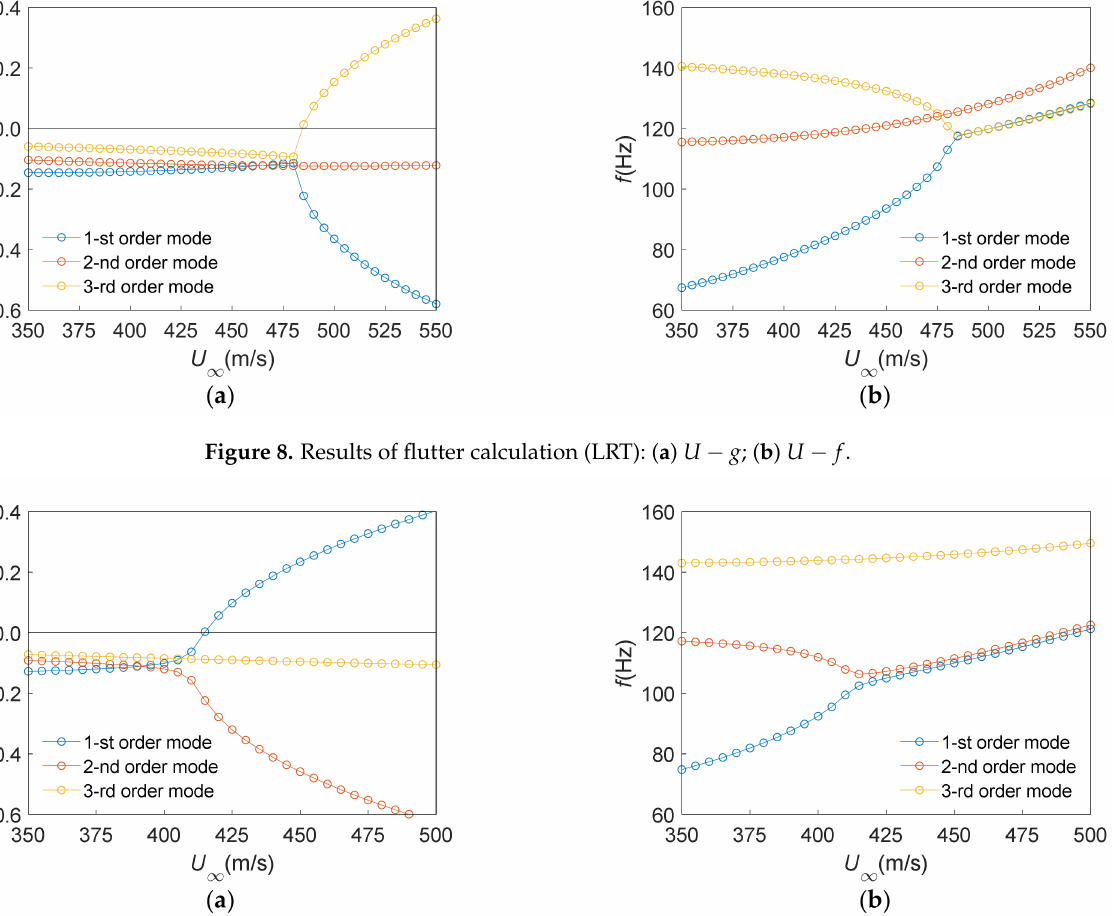
Figure 9. Results of flutter calculation (LFB): ( a ) U − g ; ( b ) U − f